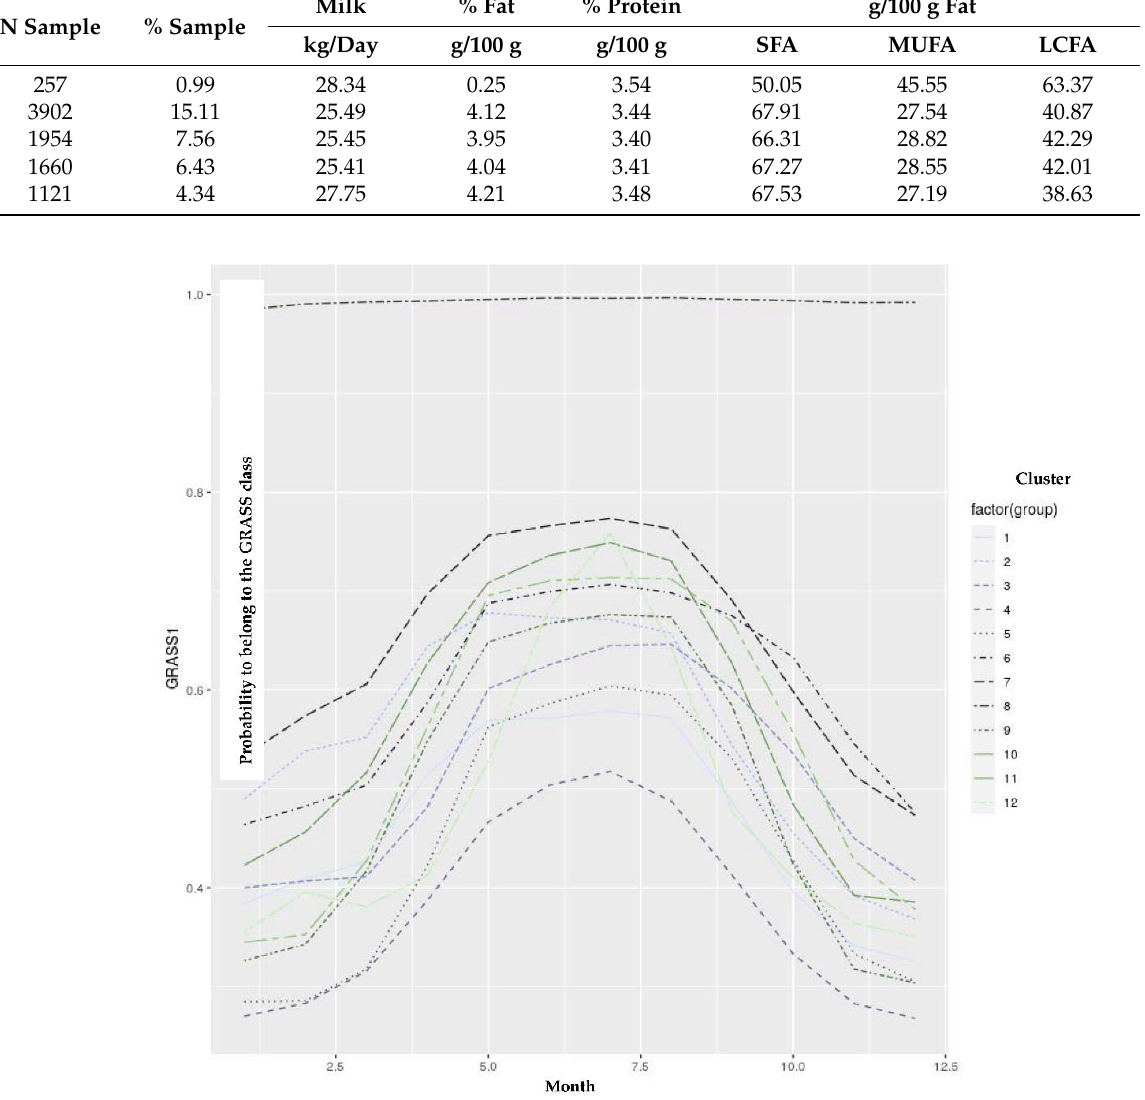
Figure 7. Dendrogram established from hierarchical clustering using the average monthly probability values for belonging to the GRASS1 cluster.